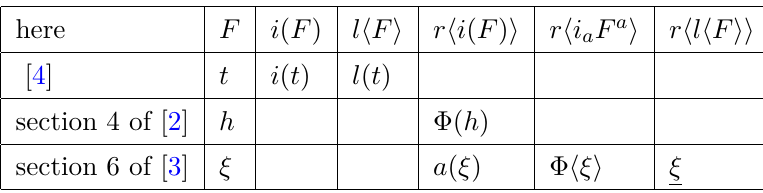
Table 1 . Summary of